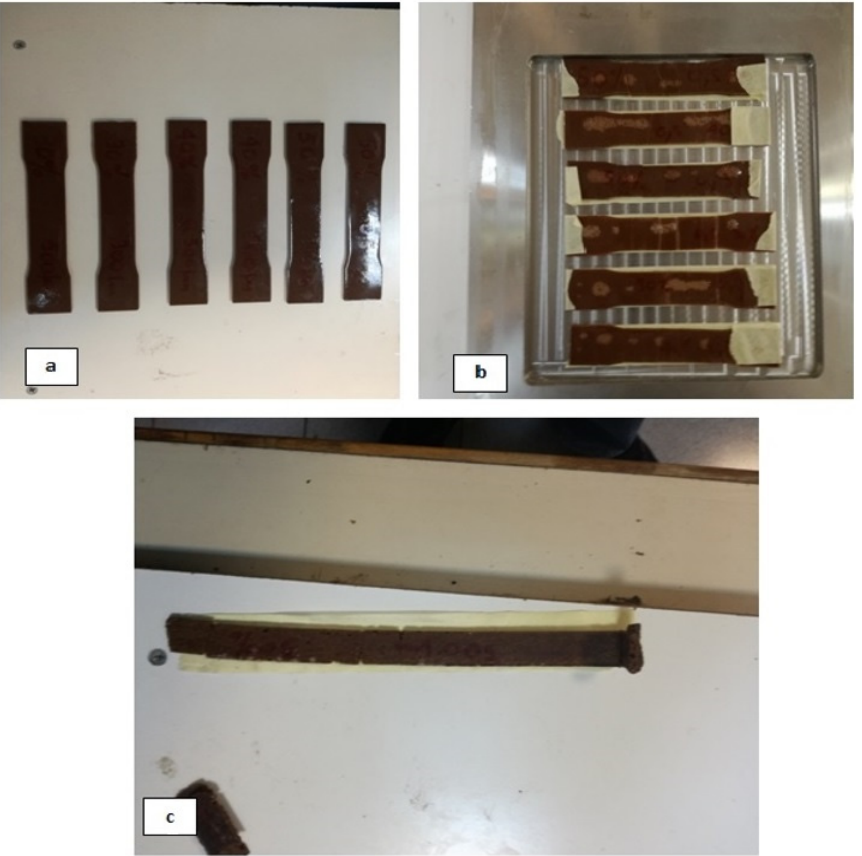
Figure 1. The three-point method set up used for bending and shears properties measurement.